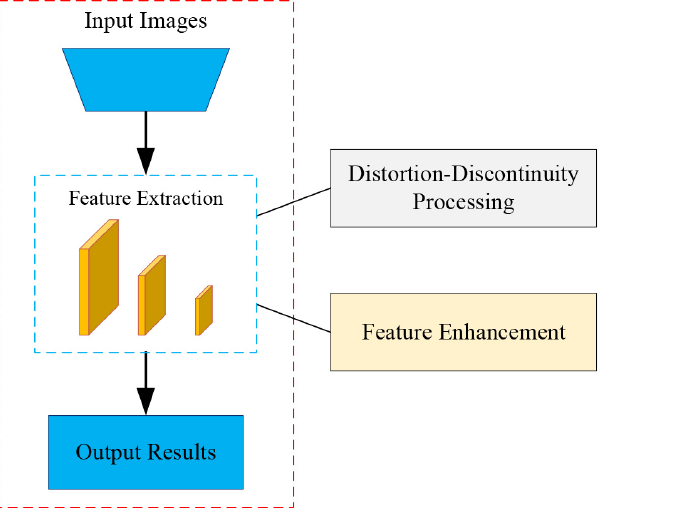
Figure 2. Diagram of the overall network structure giving a brief description of the method in this paper, where distortion and discontinuity processing and feature enhancement are performed in the feature-extraction stage.